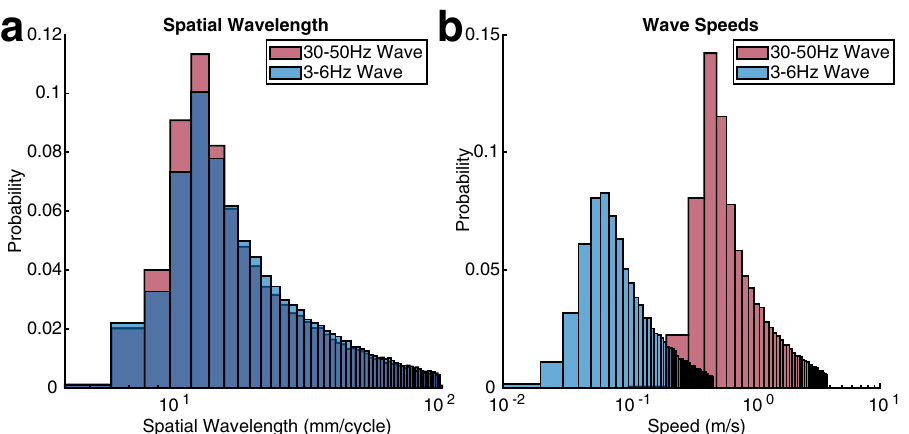
Fig.5|Fastandslowvisual-evokedwaveshavesimilarspatialwavelengthsbut signi fi cantly different propagation velocities. a Distribution of spatial